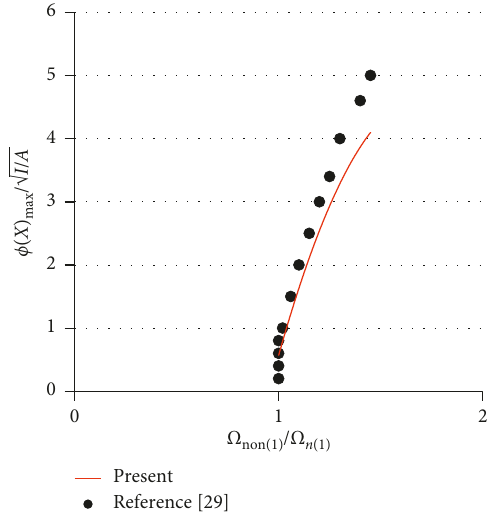
Figure 8: Comparison of backbone curves for the 1 st mode of the clamped-clamped